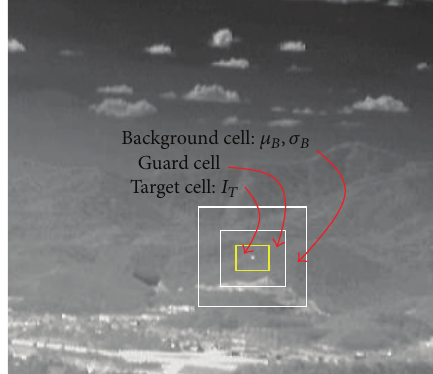
Figure 4: SCR estimation, target cell, guard cell, and background cell are selected using the clustering